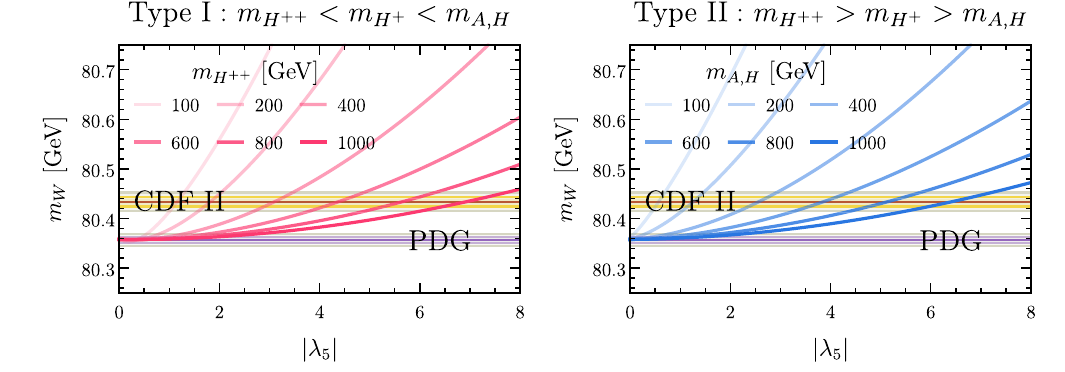
Fig. 1 One-loop corrected W boson mass m W as a function of the (right) panel. Different curves in each panel represent different masses − m 2 | /v 2 for various masses of the light- coupling | λ 5 | = 4 | m 2 for the lightest state. The brown (dark purple) line represent the CDF H + H ++ est state in the HTM. We assume the mass hierarchy of the new states II measured (PDG) value and the yellow (purple)/gray band shows the following m H ++ < m H + < m A ( m H ++ > m H + > m A ) in the left 1 σ /2 σ intervals